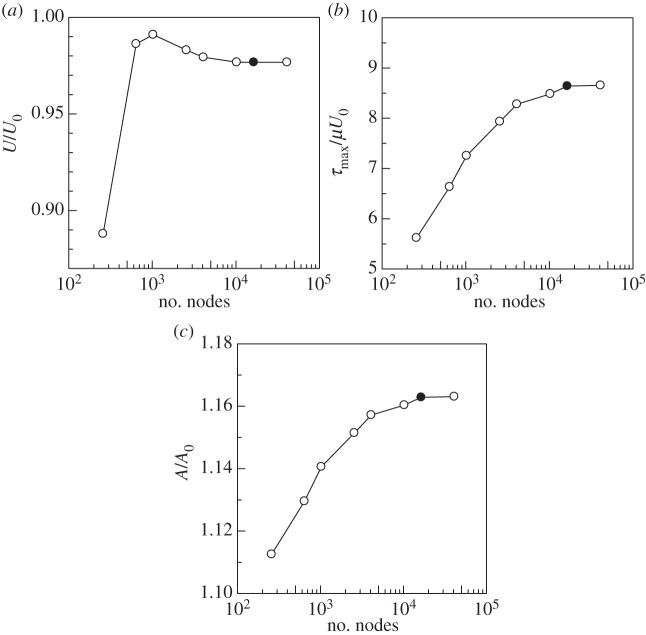
Effects of node number on the deformation and swimming motion of a torque swimmer (α=1, Ca=0.5, Gr=0). The black circle indicates the node number of 16 386, which was used throughout the study. (a) Swimming velocity U, (b) maximum tension τmax and (c) total surface area of the membrane A.